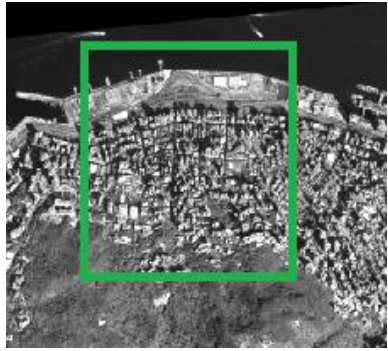
Fig.6 The DSM from the proposed method in Vaihingen